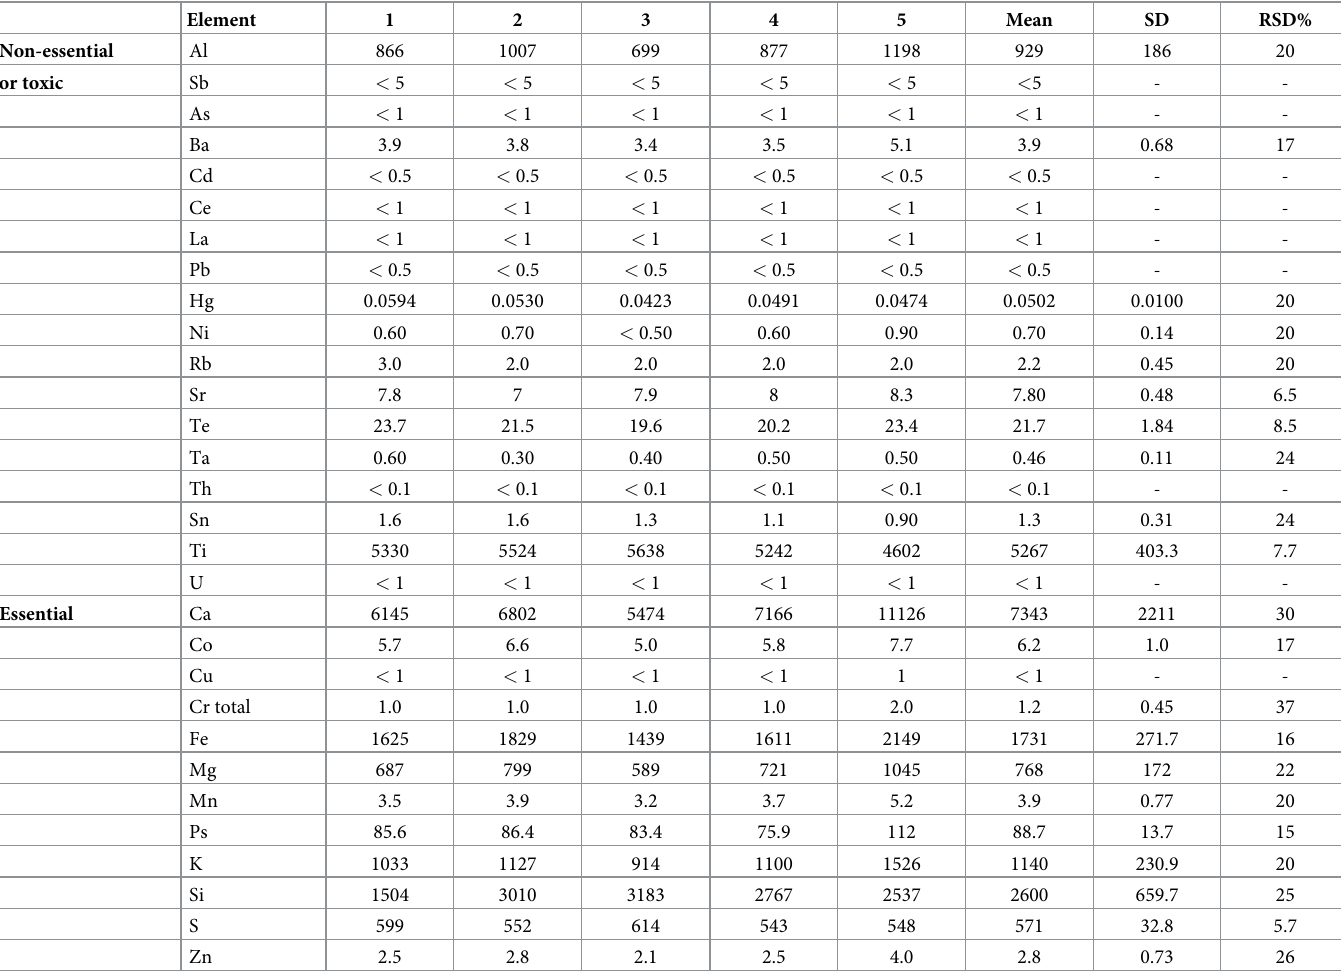
Table 2. Element concentrations (mg/g) (5 replicates), mean, standard deviation (SD) and relative standard deviation (RSD%) in 16 cigarette butts from eight com- mon brands. Element